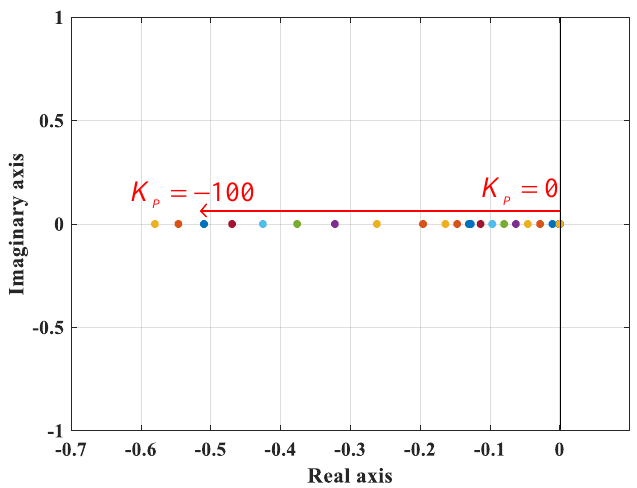
Figure 7. Eigenvalues of the P matrix for negative values of K P and K i =